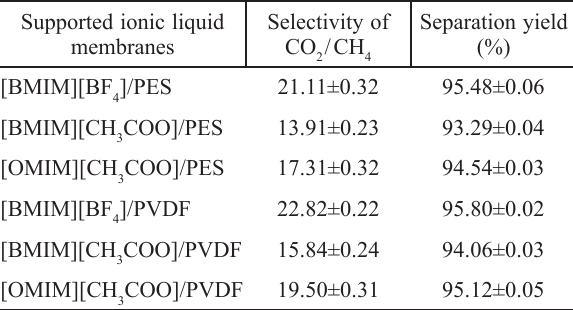
/ CH selectivity and performance of SILMs in Table 9 – CO 2 4 case of gas mixture Supported ionic liquid